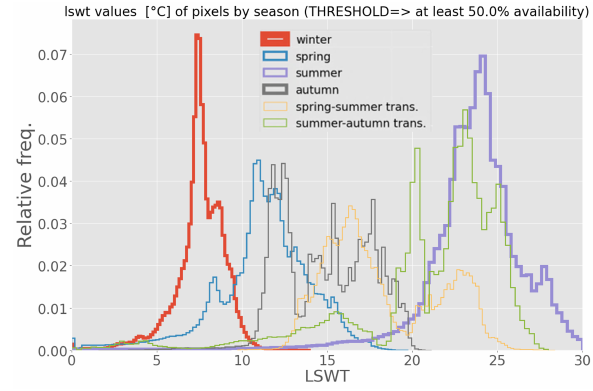
Figure 11. Histograms per season- LSWT (Three